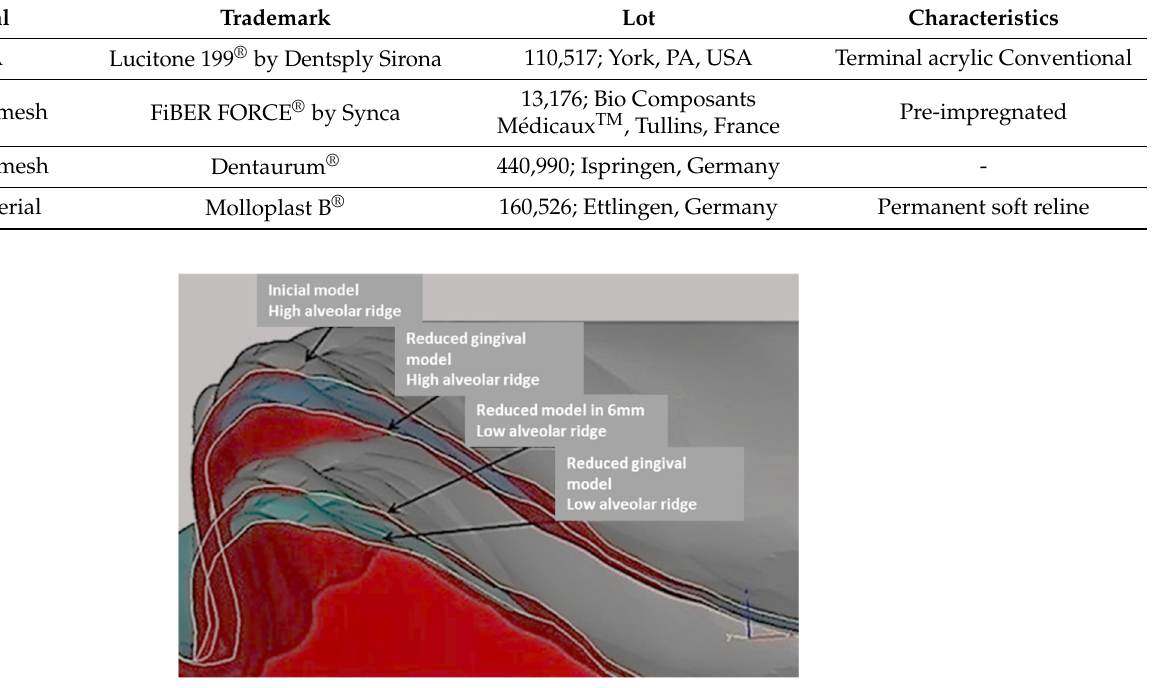
Figure 3. Titanium reduced gingival, high-alveolar-ridge model for mechanical tests. Figure 4. Reduced gingival, high alveolar ridge model with a healthy gingival mucosa replica made using silicone shore A-30. Eighty acrylic base test specimens were built with a cobalt–chromium spacer (cobalt– chromium dental alloy, Co-Cr) using conventional techniques according to the manufac- turer’s recommendations for each reinforcement or rebase material (Figure 5).